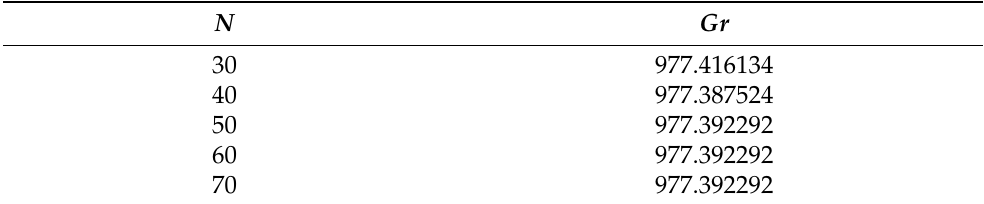
Table 1. The values of the Grashof number Gr for different number of collocation points N